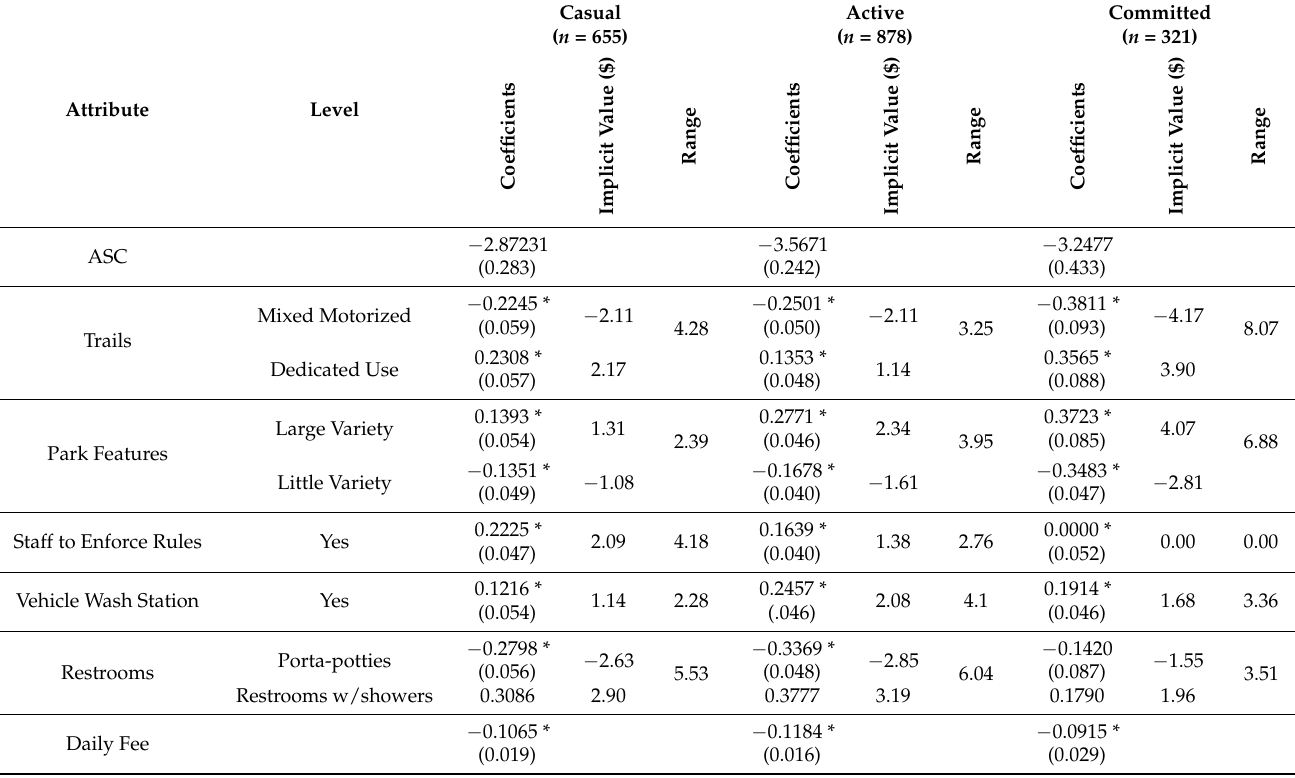
Table 2. Summary of choice model findings by recreation specialization level.